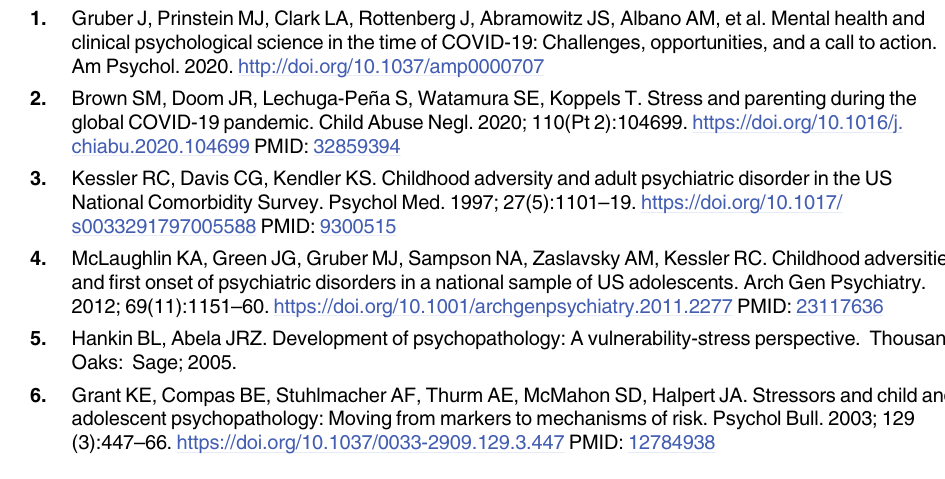
domain (S1 Table), distribution of potential protective factors and psychopathology symp- toms (S2 Table), bivariate correlation table of all study variables (S3 Table), associations between individual stressors and psychopathology symptoms (S4 Table), age by screen time interaction predicting internalizing symptoms (S1 Fig), and the full COVID experi- ences surveys (caregiver and